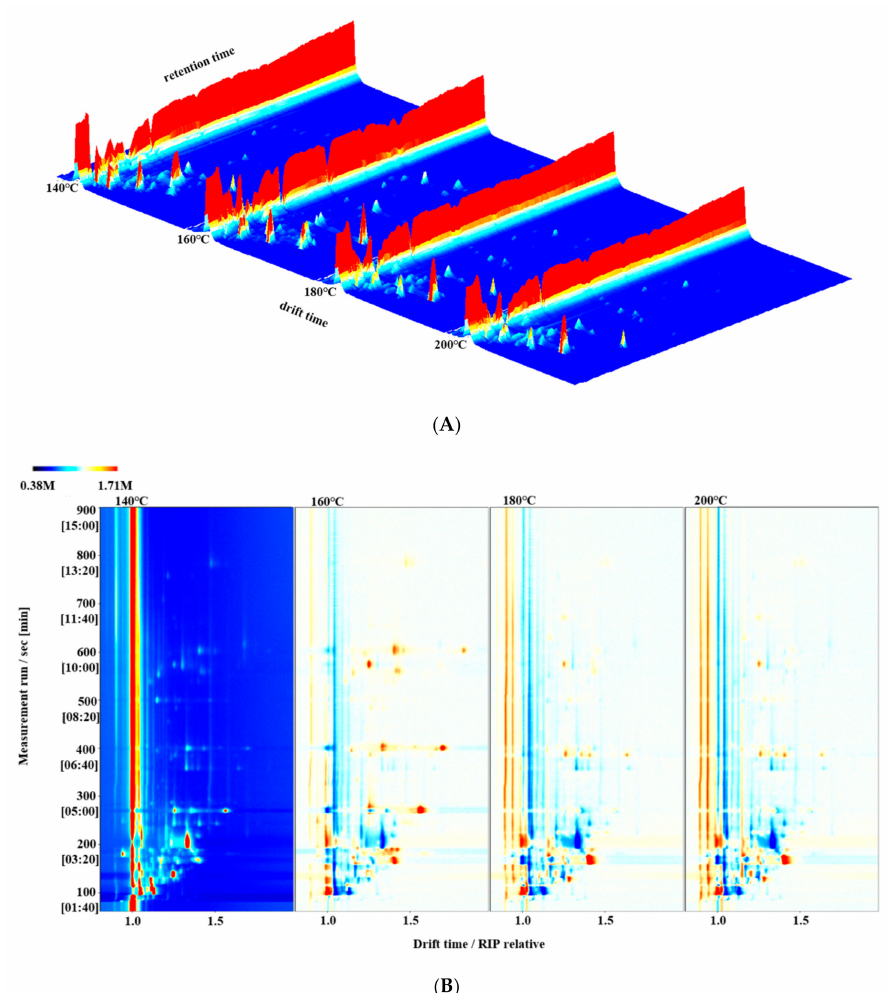
Figure 5. 3D-topographic plots ( A ) and 2D-topographic plots ( B ) of volatile organic compounds in fish filets fried at different temperatures with a moisture content of 65%. Note: The X -axis represented the ion drift time of volatile organic compounds, the Y -axis represented the gas phase retention time, and the Z -axis represented the peak